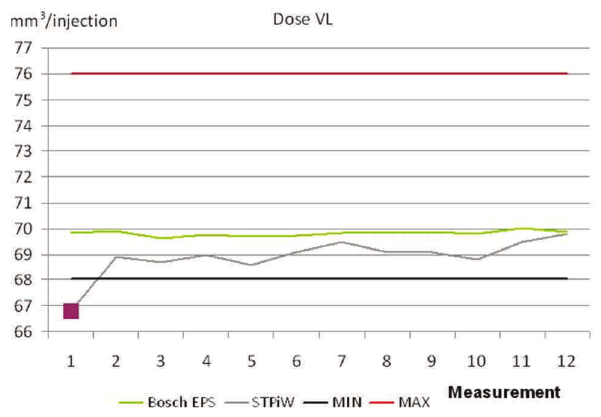
Fig. 6. VL test (actuation time 1300 µs, pressure 130 MPa)